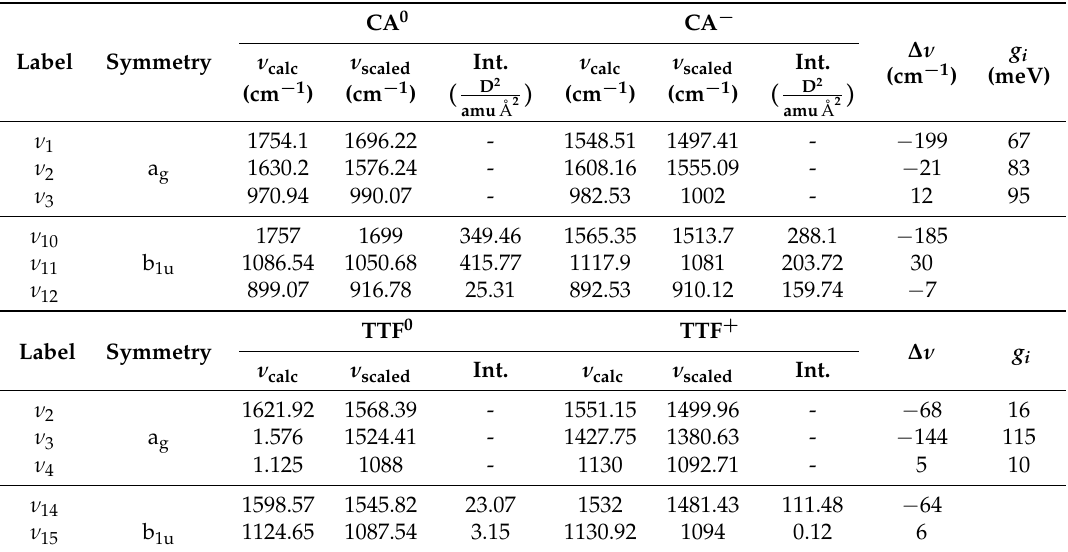
Table 2. Calculated resonance frequencies in wavenumbers, infrared intensities (Int.) and electron-molecular vibrational (emv) coupling constants g i